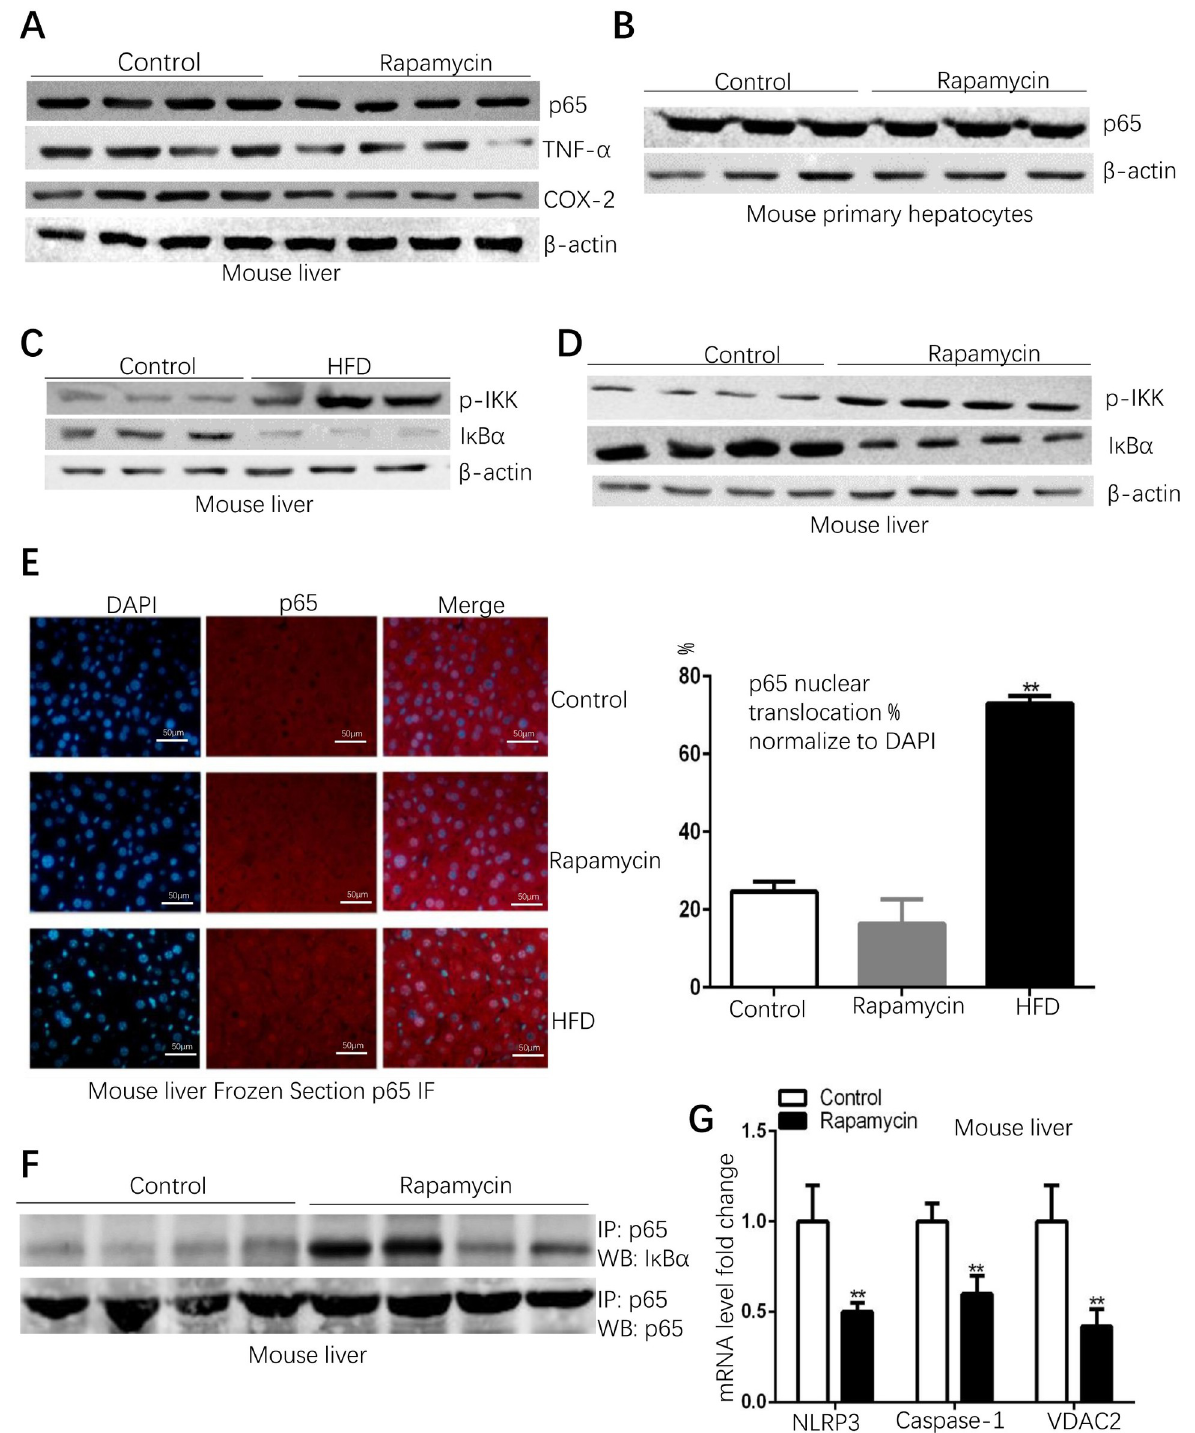
Fig 3. Rapamycin enhances the interaction between p65 and I κ B α to block the NF κ B pathway. (Data represent mean ± SD, �� p < 0.01, � p < 0.05). A. Lower expressions of pro-inflammatory genes in rapamycin-induced fatty liver. (Control group n = 4, rapamycin group n = 4). B. p65 protein level was not changed in mouse primary hepatocytes. C. Increased phosphorylation level of IKK and decreased I κ B α level in high fat diet (HFD)-induced fatty livers (Control group n = 3, HFD group n = 3). D. Increased phosphorylation level of IKK and decreased I κ B α level in rapamycin-induced fatty livers (Control group n = 4, rapamycin group n = 4). E. Increased p65 nuclear translocation in HFD-induced fatty livers; p65 nuclear translocation was not increased in rapamycin-induced fatty livers. F. Interaction between p65 and I κ B α has enhanced in rapamycin-